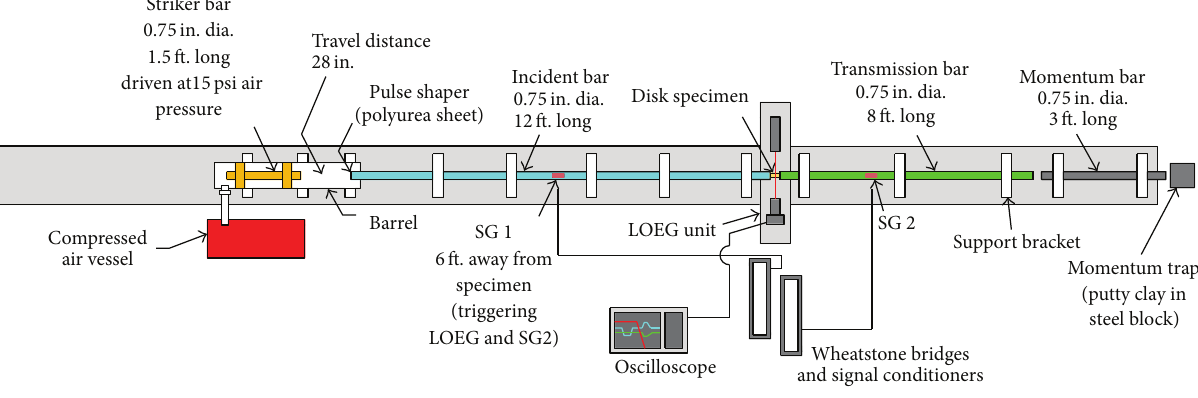
Figure 4: SHPB setup for indirect tensile tests including Laser Occluding Expansion Gage (LOEG)